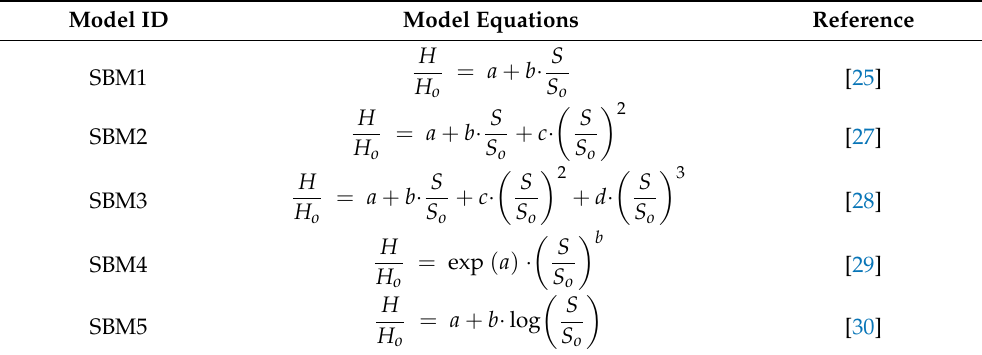
Table 4. Sunshine-based models used in this